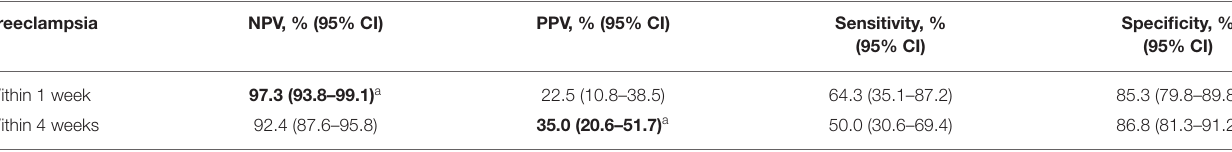
TABLE 2 | Performance of the sFlt-1/PlGF ratio using a cutoff of 38 for short-term prediction of preeclampsia. Preeclampsia